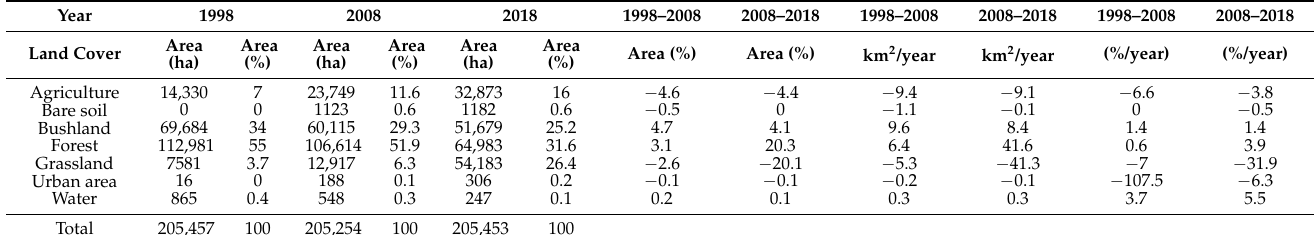
Table 6. Land-cover class area (in ha and %) over the years 1998–2018 and annual rate of change (in %/year and km 2 /year) in the Wami Mbiki–Saadani (WMS) wildlife corridor. Land-cover classes are defined in Table